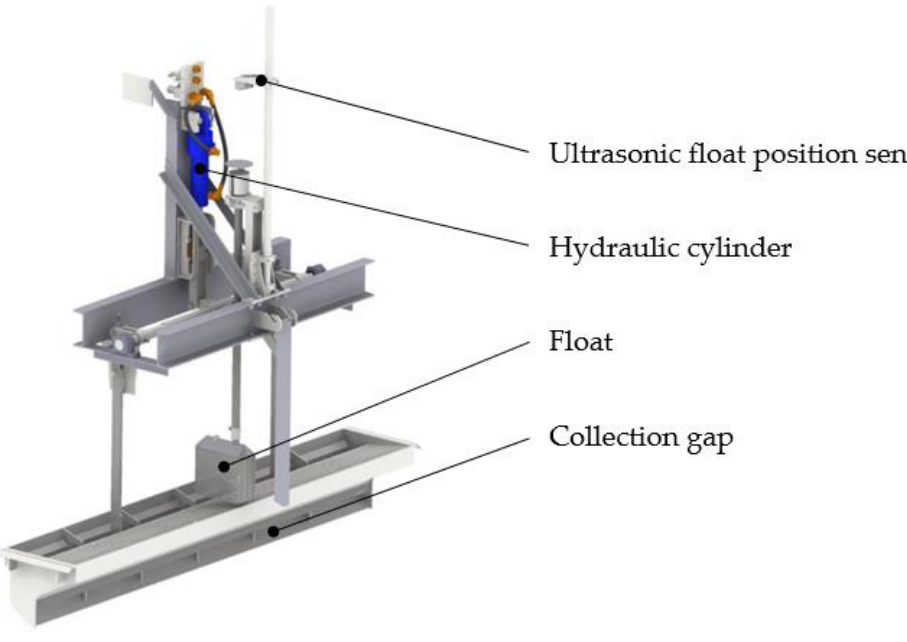
Figure 2. Culvert system in jigs.